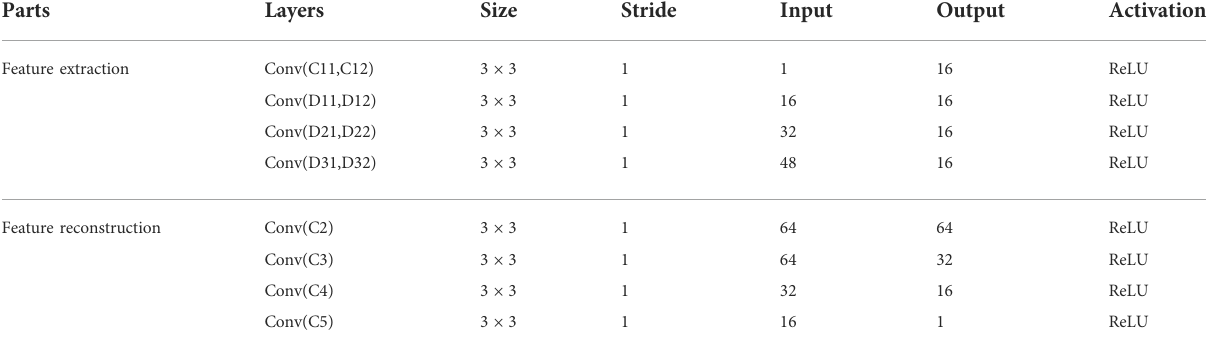
TABLE 1 Architecture of the network. Parts Layers